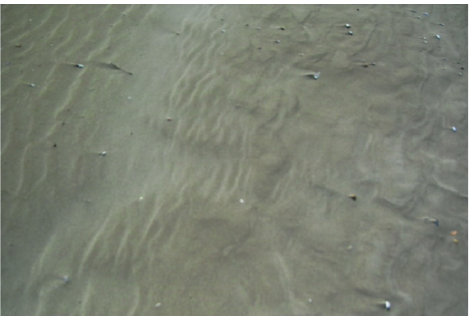
Figure 1. Types of sand textures on Mediterranean